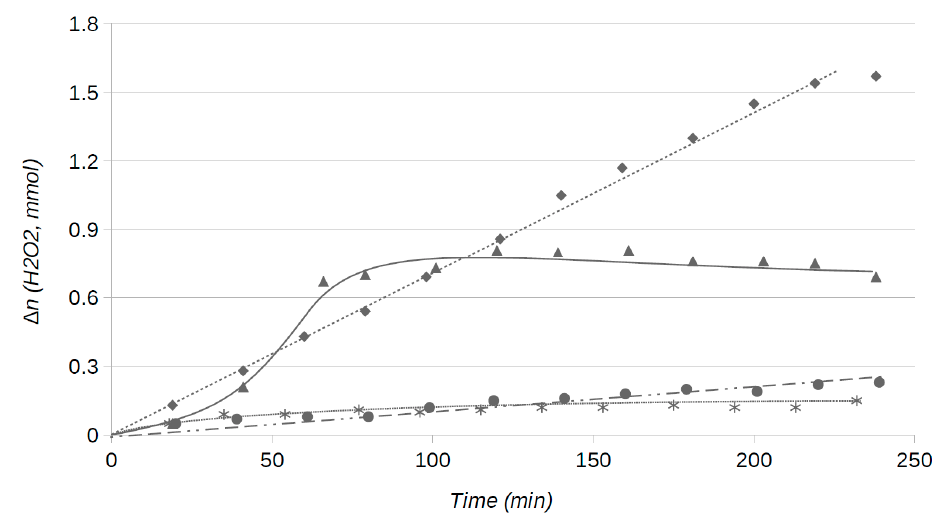
Figure 4. Overall amount of H 2 consumed (mmol) and of H 2 O 2 formed (bottom, mmol) over 100 mg of freshly prepared catalysts (used within 24 h from the end of preparation) as a function of time (lines in the bottom panel are intended to serve only as guides to the eye).